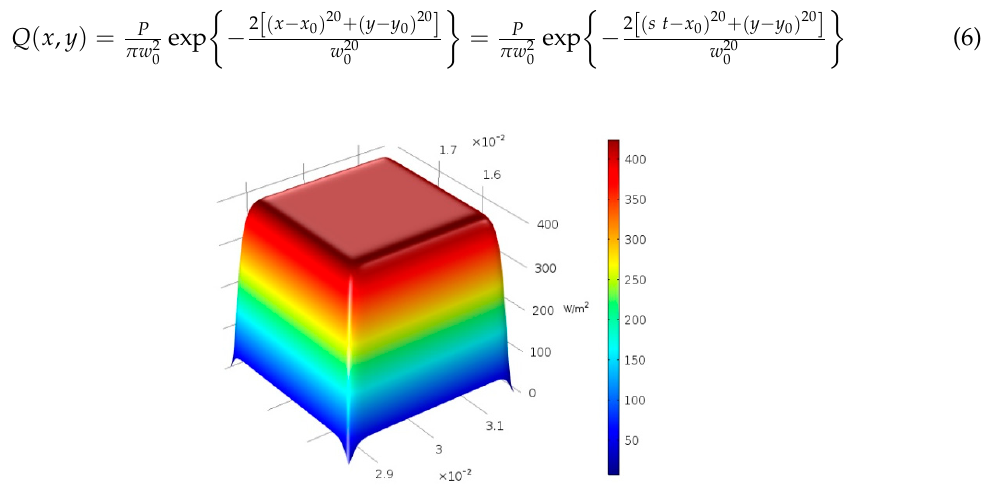
Figure 1. Distribution of transverse optical intensity: Super-Gaussian profile of order 20.